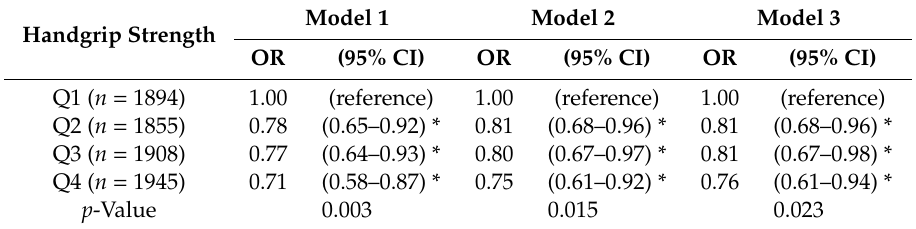
Model 1: adjusted for age, sex, education level, household income. Model 2: adjusted for Model 1 covariates plus smoking status, alcohol consumption, and physical activity level. Model 3: adjusted for Model 2 covariates plus body mass index. * p -value < 0.05 versus reference group.